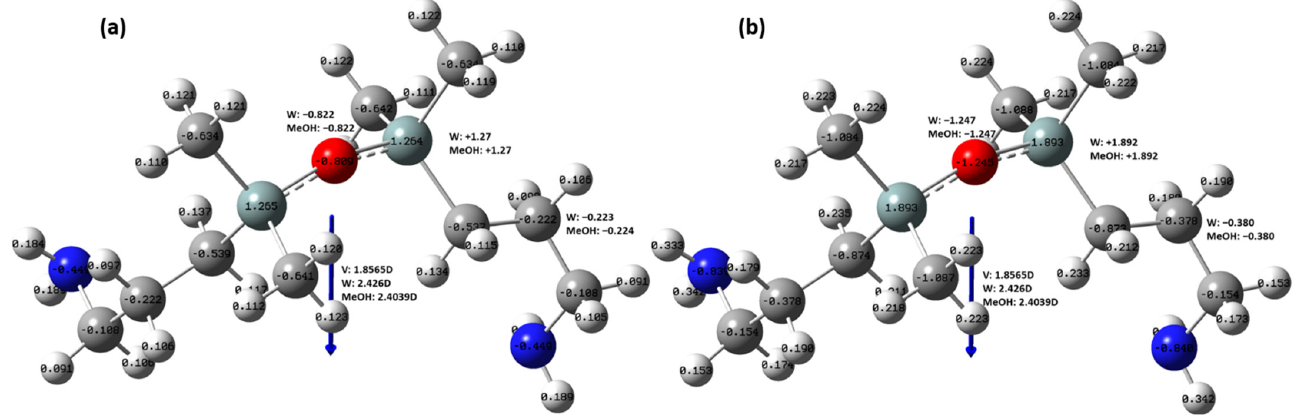
Figure 5. Partial charges for APTMDS: ( a ) Mulliken, ( b ) NPA from NBO; implicit solvents: W—